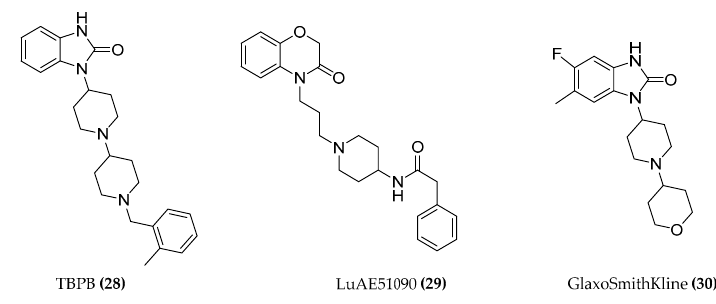
Figure 11. Structures of M1 allosteric agonists.